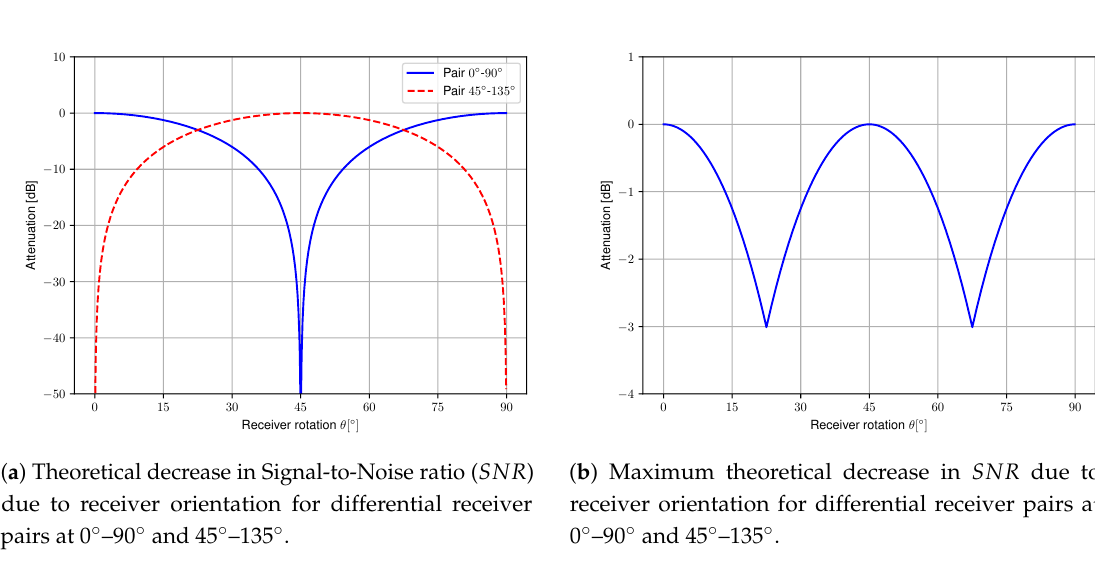
Figure 3. Theoretical decrease in SNR due to receiver orientation for two differential receiver